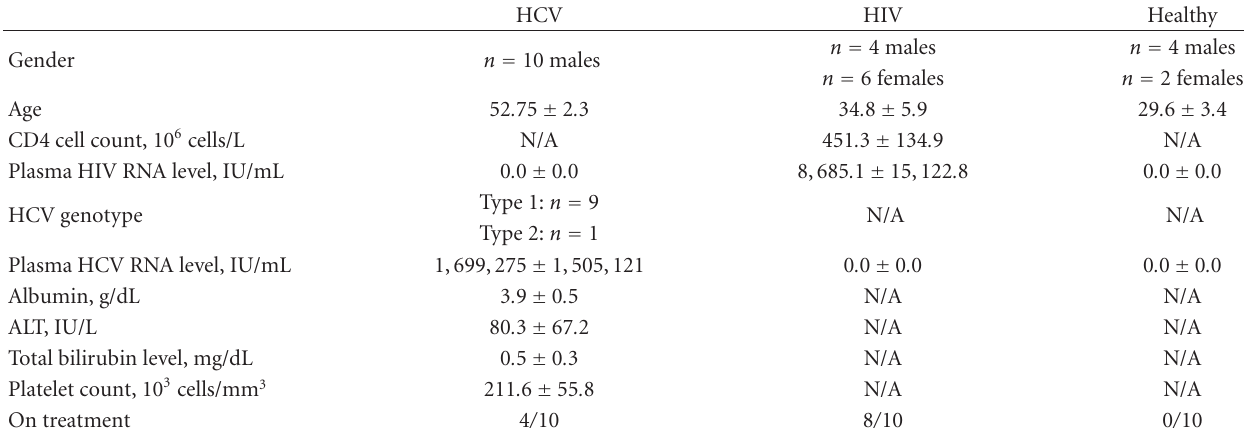
Table 1: Clinical characteristics of study subjects. Data are given as means ± SD, unless otherwise specified. HCV: hepatitis C virus; HIV: human immunodeficiency virus; ALT: alanine aminotransferase; N/A: not